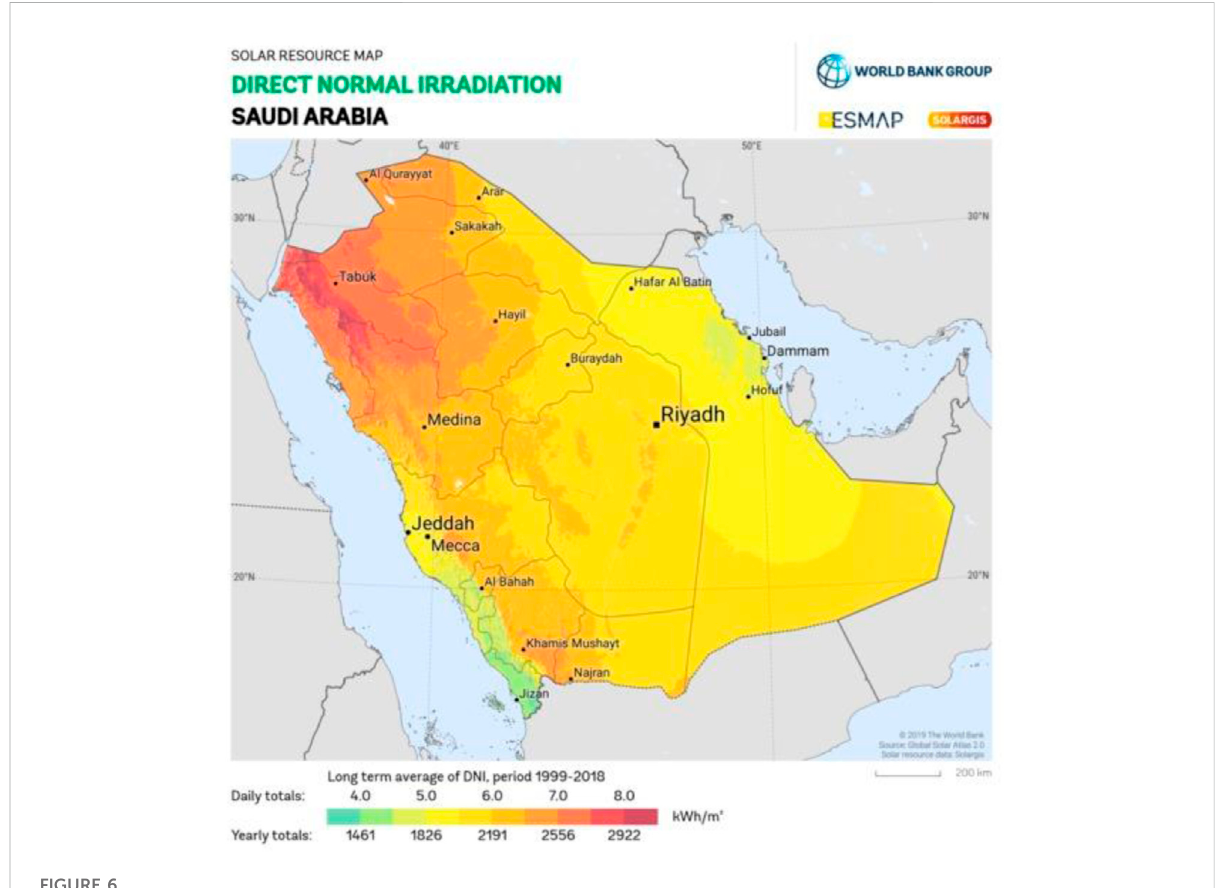
FIGURE 6 Solar map of Saudi Arabia (Solargis,